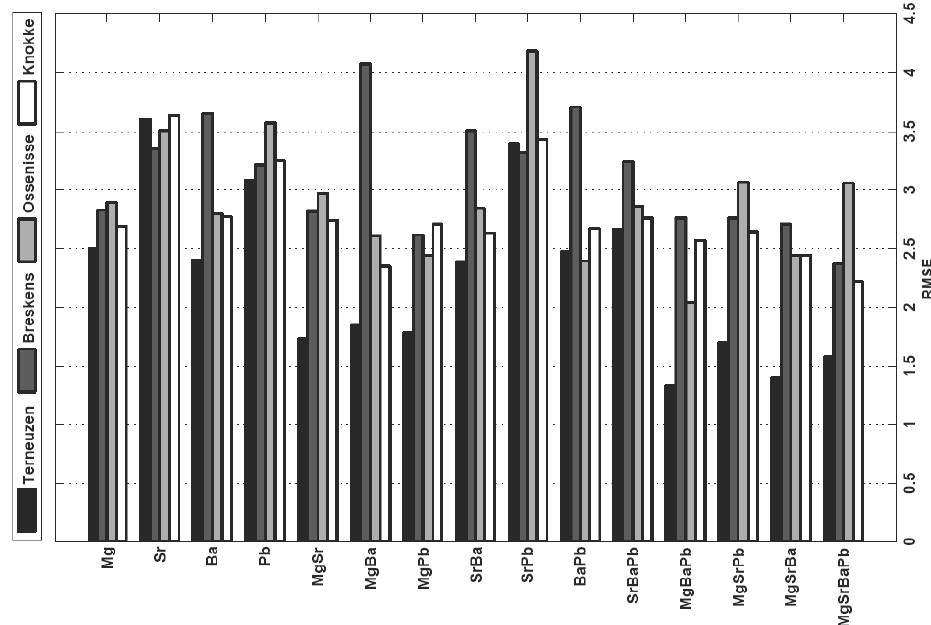
Fig. 7. Model reconstruction performance expressed as RMSE obtained on the validation data for the four sites, as based on the Terneuzen training dataset using different proxy